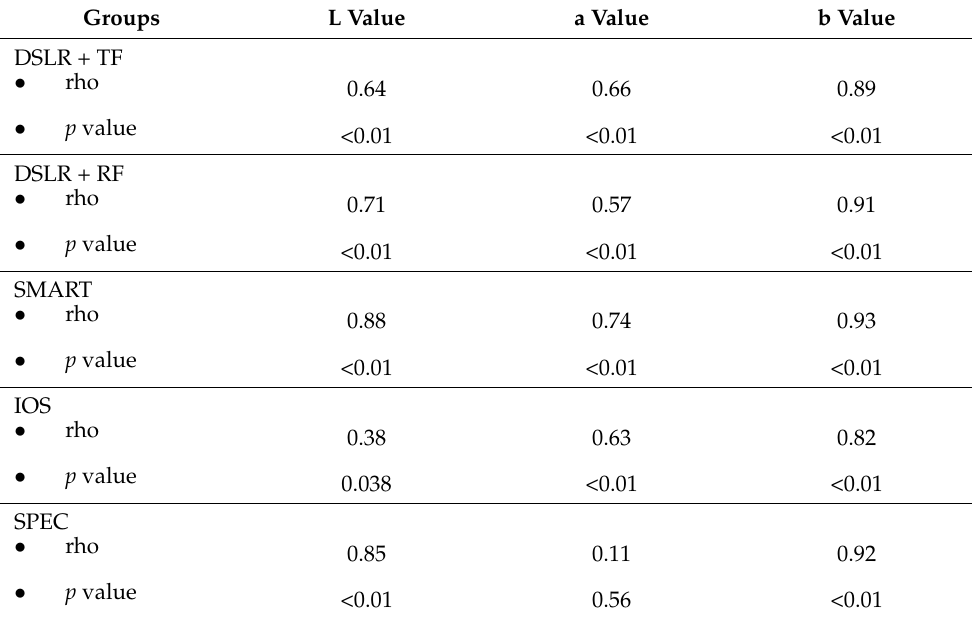
Table 8. Correlation of various methods with the control